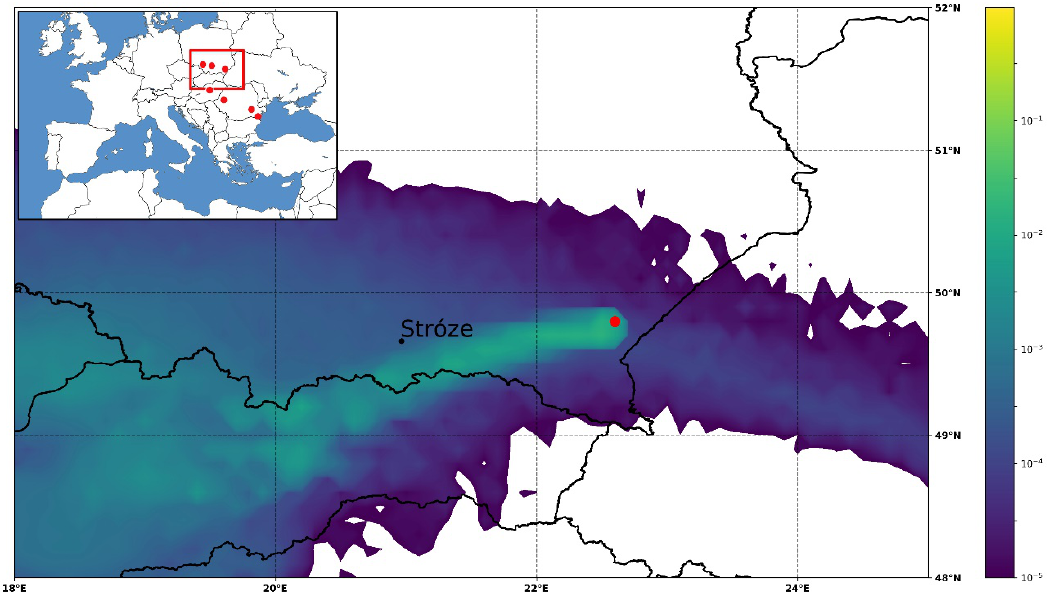
Figure 6. An episode of air mass possibly transporting microfossils from the emission area (red dot) to the honey harvesting area near Stróze, Poland; shown on an atmospheric dispersion sensitivity map [m − 3 ] for the dust deflated on 26 August 2013. Red dots on the small map show the distribution of Oligocene-Miocene diatomites.